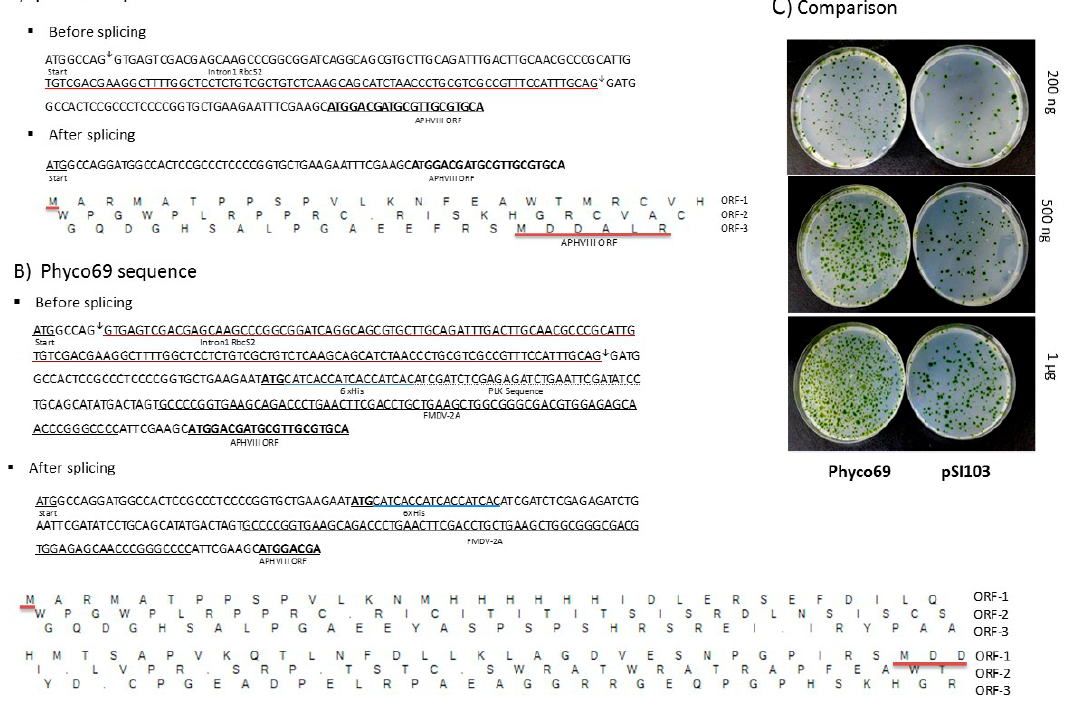
Figure A2. Average survival Chlamydomonas clones transformed with the plasmid Phyco69BLE and cultured with increasing concentrations of paromomycin ( A ) or phleomycin ( B ). Values are the average of at least three replicates and bars represent the standard deviation.